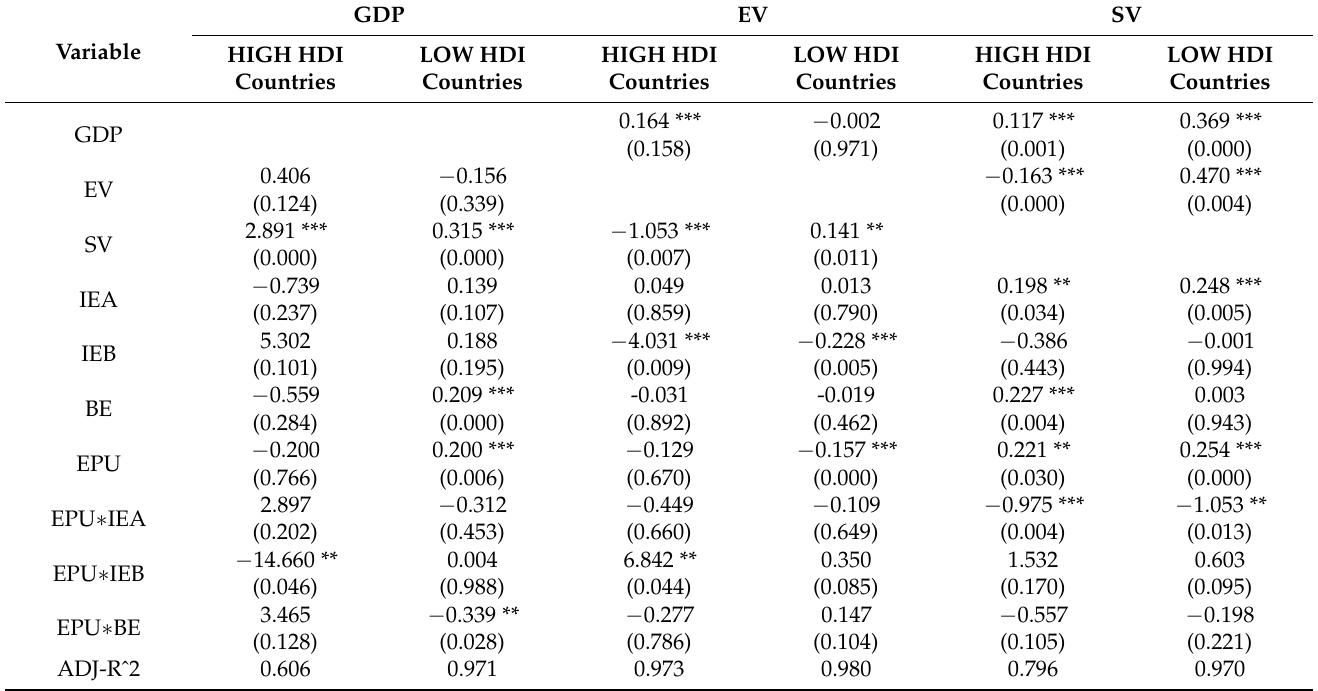
Table 8. Heterogeneity analysis of EPU and